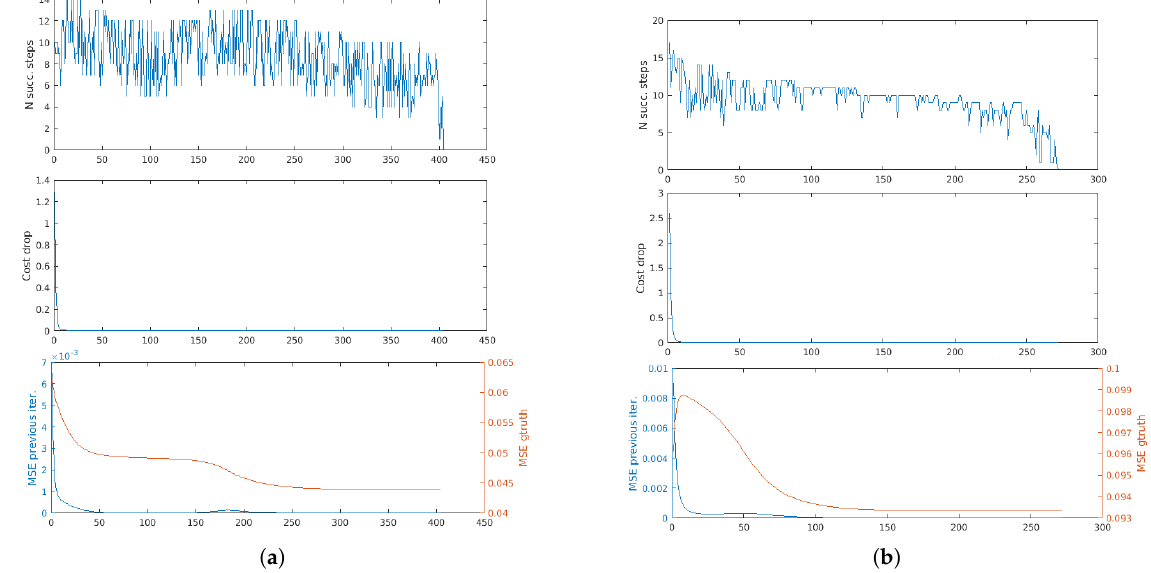
Figure 6. Termination criteria for two point clouds from the Stanford Bunny Dataset. Initial misalignment of ( a ) 90 ◦ ( b ) 180 ◦ .